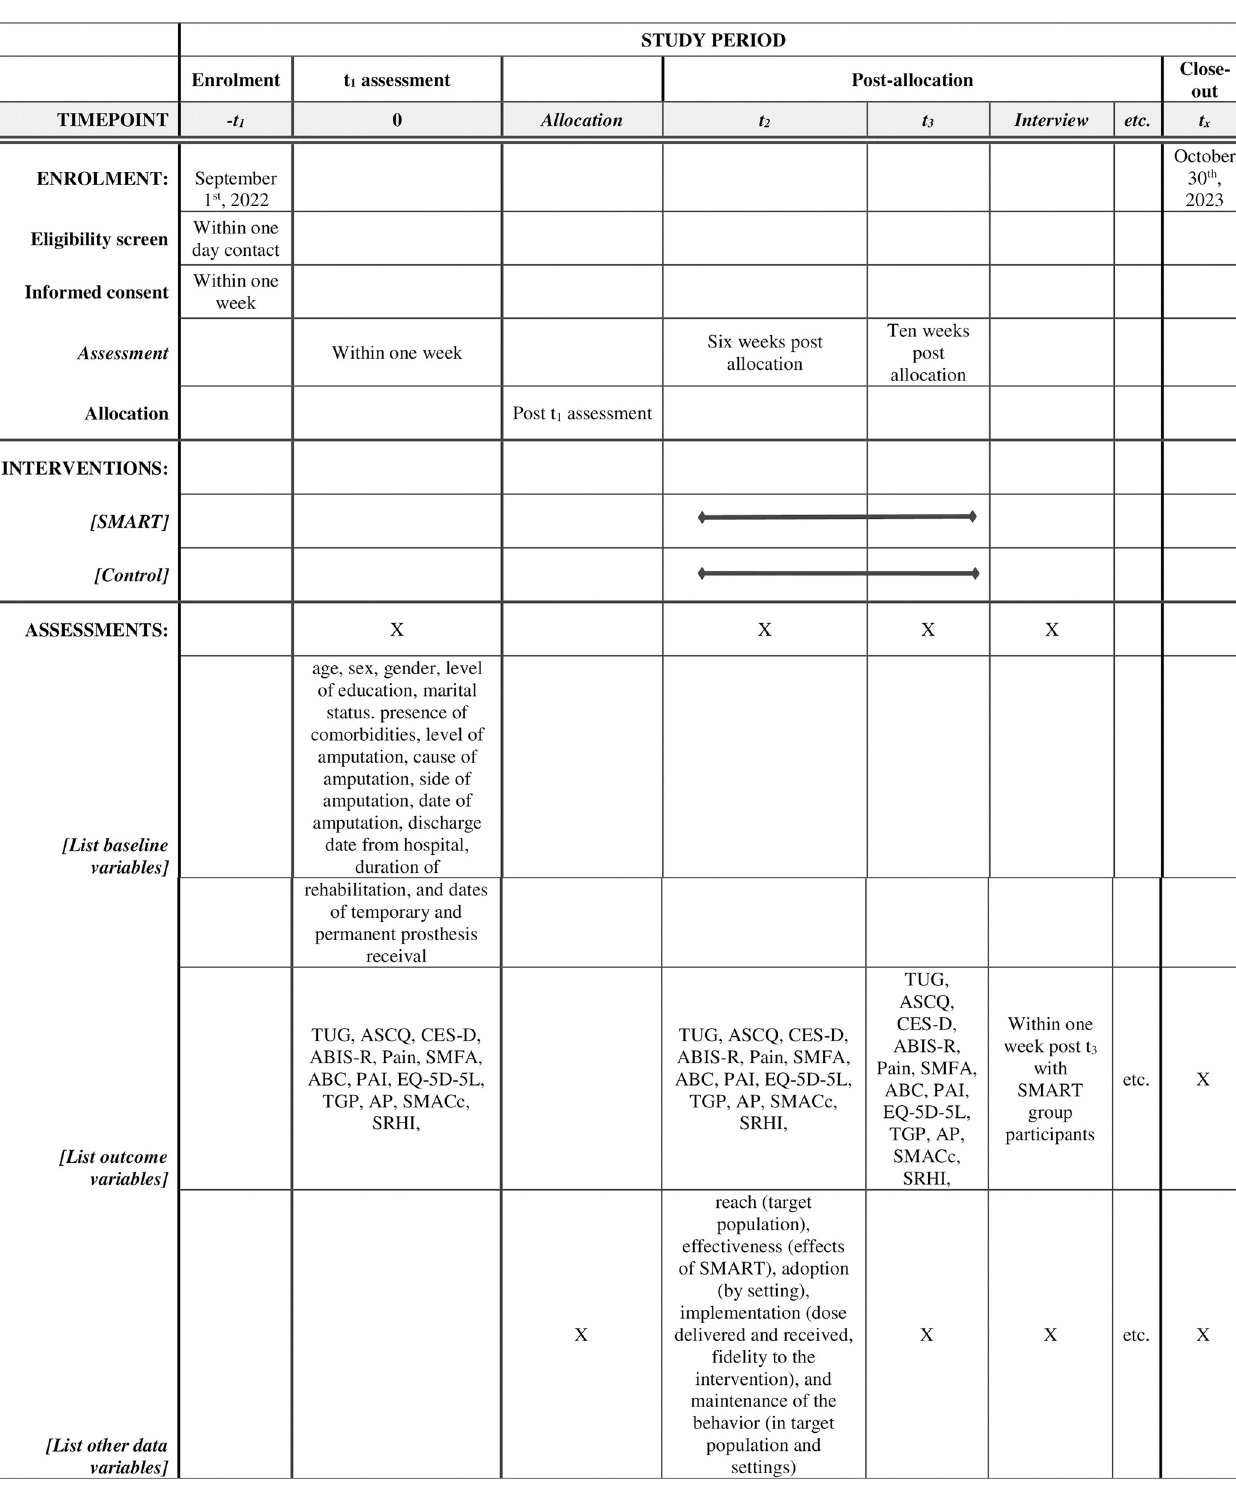
PLOS ONE | https://doi.org/10.1371/journal.pone.0278418 March 23,